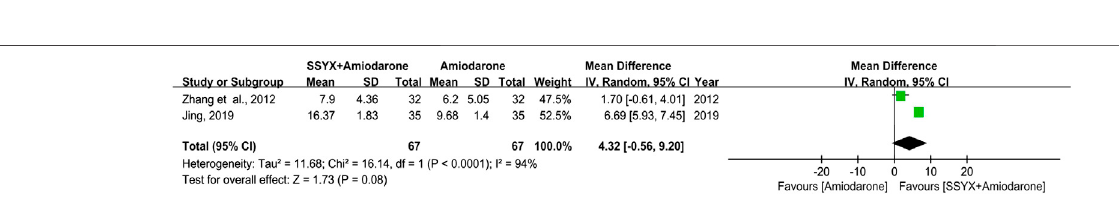
FIGURE 5 | Forest plot of comparison: SSYX-amiodarone vs. amiodarone alone: VPCs.